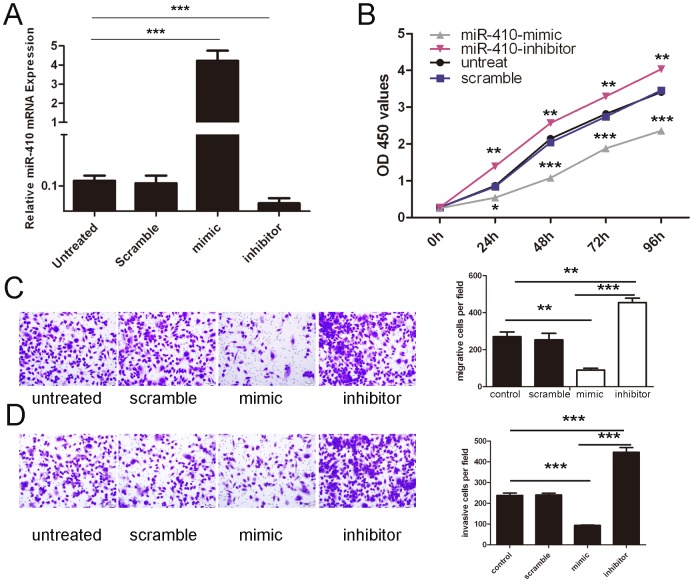
Overexpression of miR-410 inhibited the cell proliferation, migration, and invasion in gastric cancer cells (A) Expression levels of miR-410 were examined by qRT-PCR after transfection of 20 nmol/L of miR-410 mimics, inhibitors or sramble or no transfection.The expression of miR-410 was normalized to U6 snRNA. (B) The cells treated with miR-410 mimics, inhibitors or sramble or no transfection were measured by CCK8 assay at different time periods. (C) Transwell analysis of HGC-27 cells after treatment with miRNA mimics, inhibitors or scramble or no transfection; the relative ratio of migrated cells per field is shown below. (D) Transwell analysis of HGC-27 cells after treatment with miRNA mimics, inhibitors or scramble or no transfection; the relative ratio of invasive cells per field is shown below, *p<0.05, ** p<0.01, and ***p<0.001.